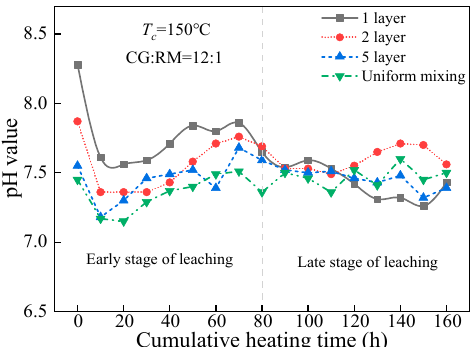
Figure 10. Variations of pH value of co-disposal leaching solution with different storage methods.